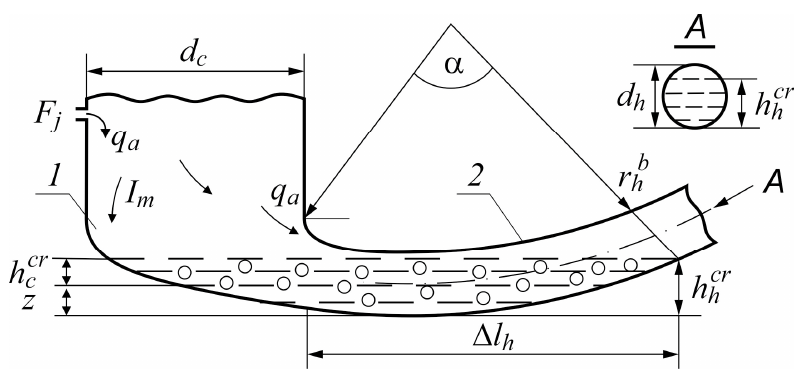
Figure 1. Hydraulic model of the formation of a critical volume of milk in the milking machine manifold (teat cups are not shown): (1) collector, (2) milk hose, ( F j ) air inlet jet, ( q a ) air flow, ( I m ) milk flow, ( d c ) collector diameter, ( d h ) hose diameter, ( ∆ l h ) hose arc length, ( h cr c ) critical milk level in the collector, ( h cr ) critical milk level in the hose, ( r b ) hose bend radius, ( z ) difference in height between the lowest point of the collector and the hose, (A) section of the hose.